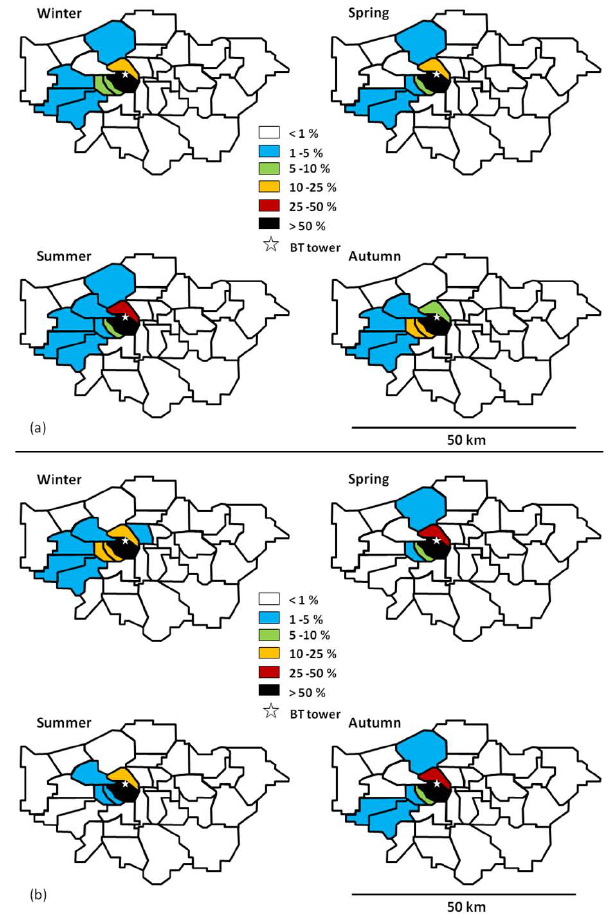
Fig. 3. Seasonal distributions during 2007 of the flux footprint of the BT Tower over Greater London. The tower footprint was cal- culated on a half-hourly basis using the Kormann-Meixner model. Seasonal averages were derived from (a) all available data, and (b) daytime (09:00-18:00) data only. The colour scale reflects the contribution of individual boroughs to the total flux footprint. Maps generated from 1km 2 grid data (as used by the NAEI).